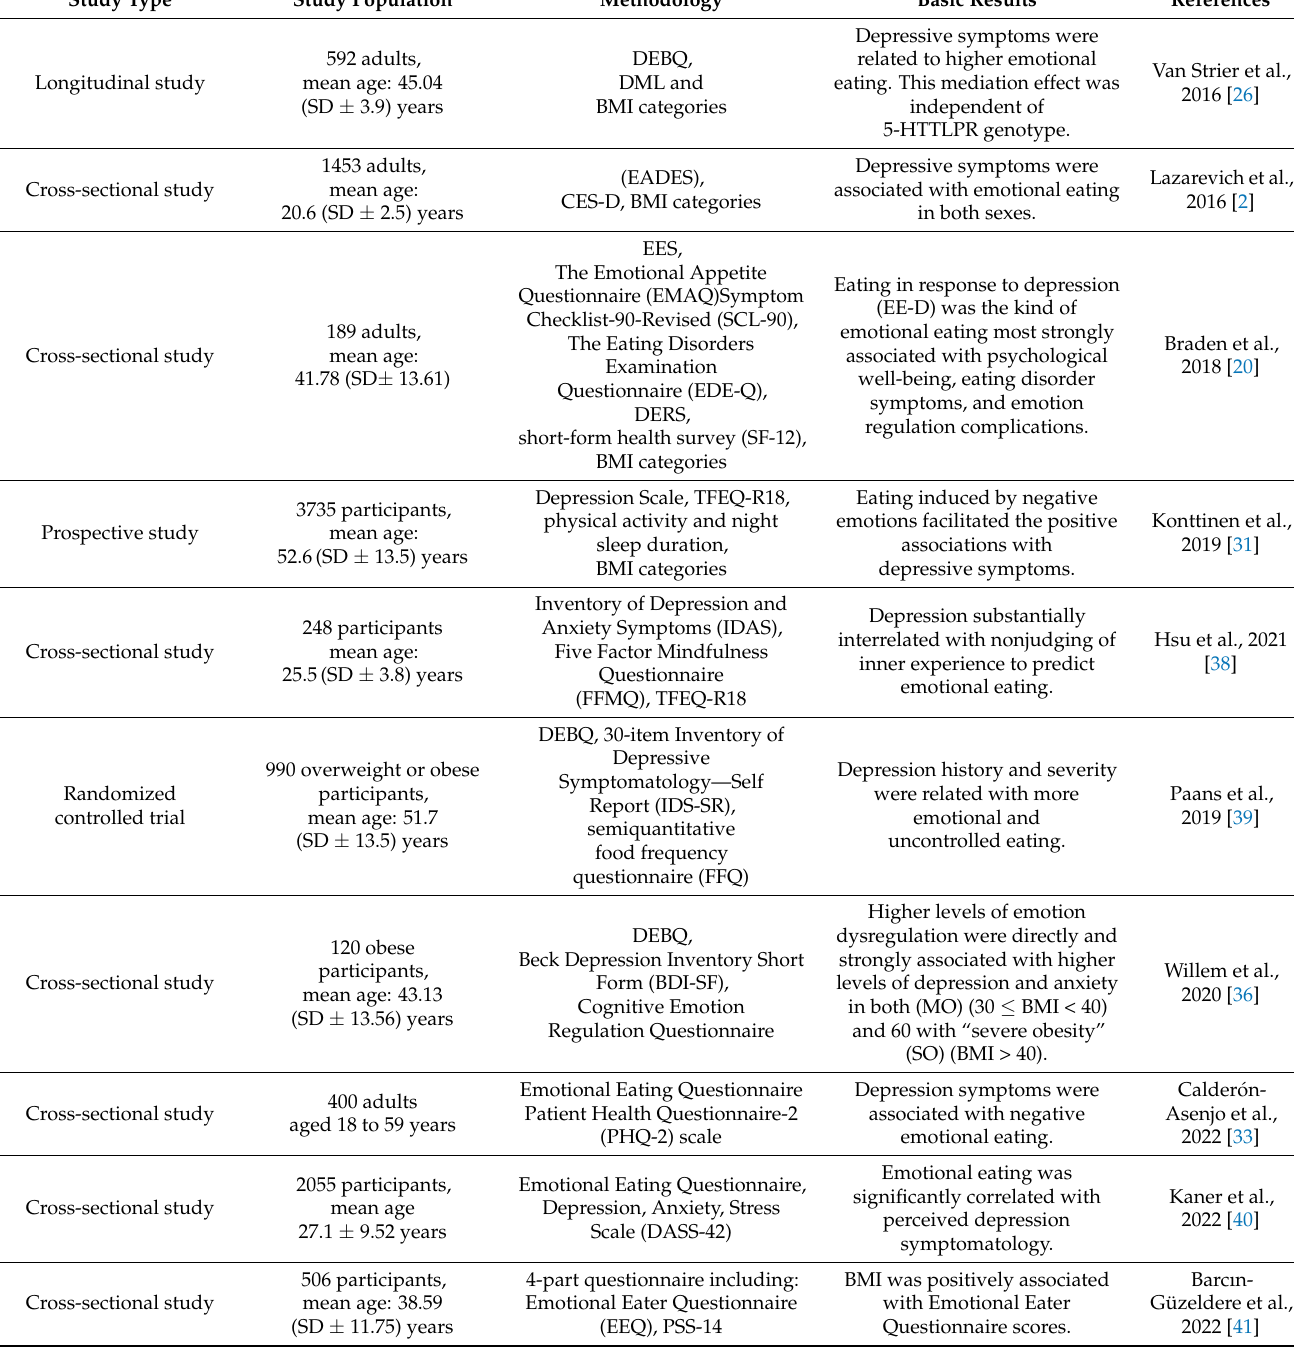
Table 2. Clinical studies evaluating the association of emotional eating with